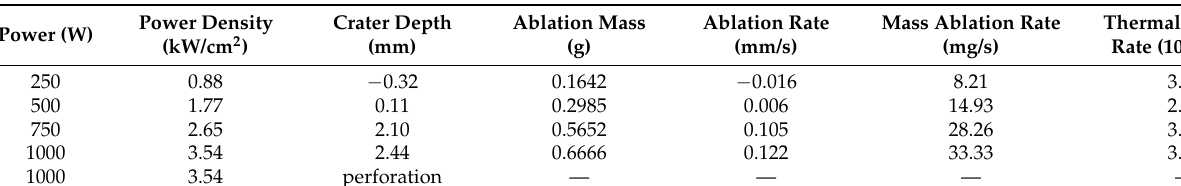
Figure 6. Ablation morphologies of CFRP laminates under VHX-100 digital microscope. ( a ) 250 W; ( b ) 500 W; ( c ) 750 W; ( d ) 1000 W. Table 2. The CFRP laminate ablation data in the atmospheric environment. Table 2. The CFRP laminate ablation data in the atmospheric environment.